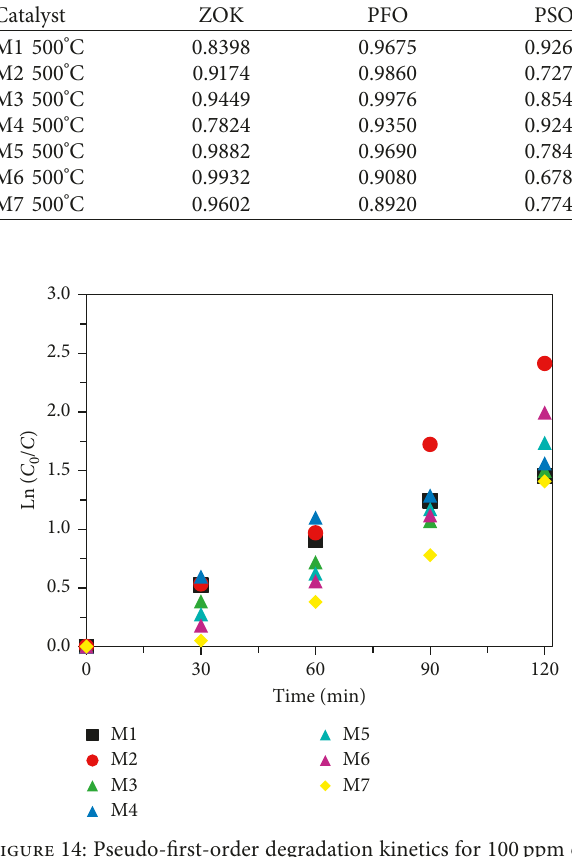
Figure 14: Pseudo-first-order degradation kinetics for 100ppm of 2,4,6-trichlorophenol with different photocatalysts.